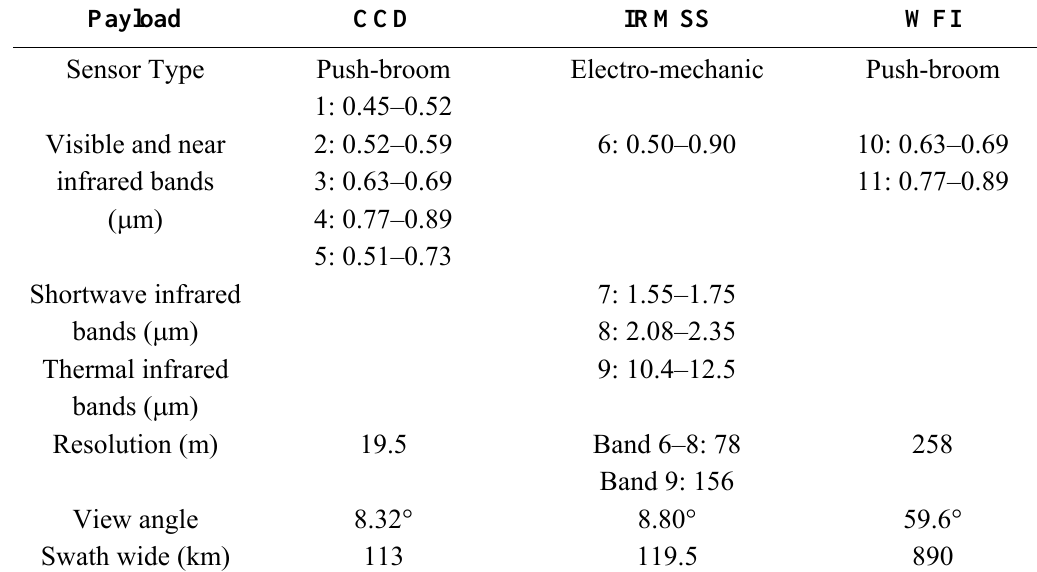
Table 3. The CBERS payloads, sensors and channels